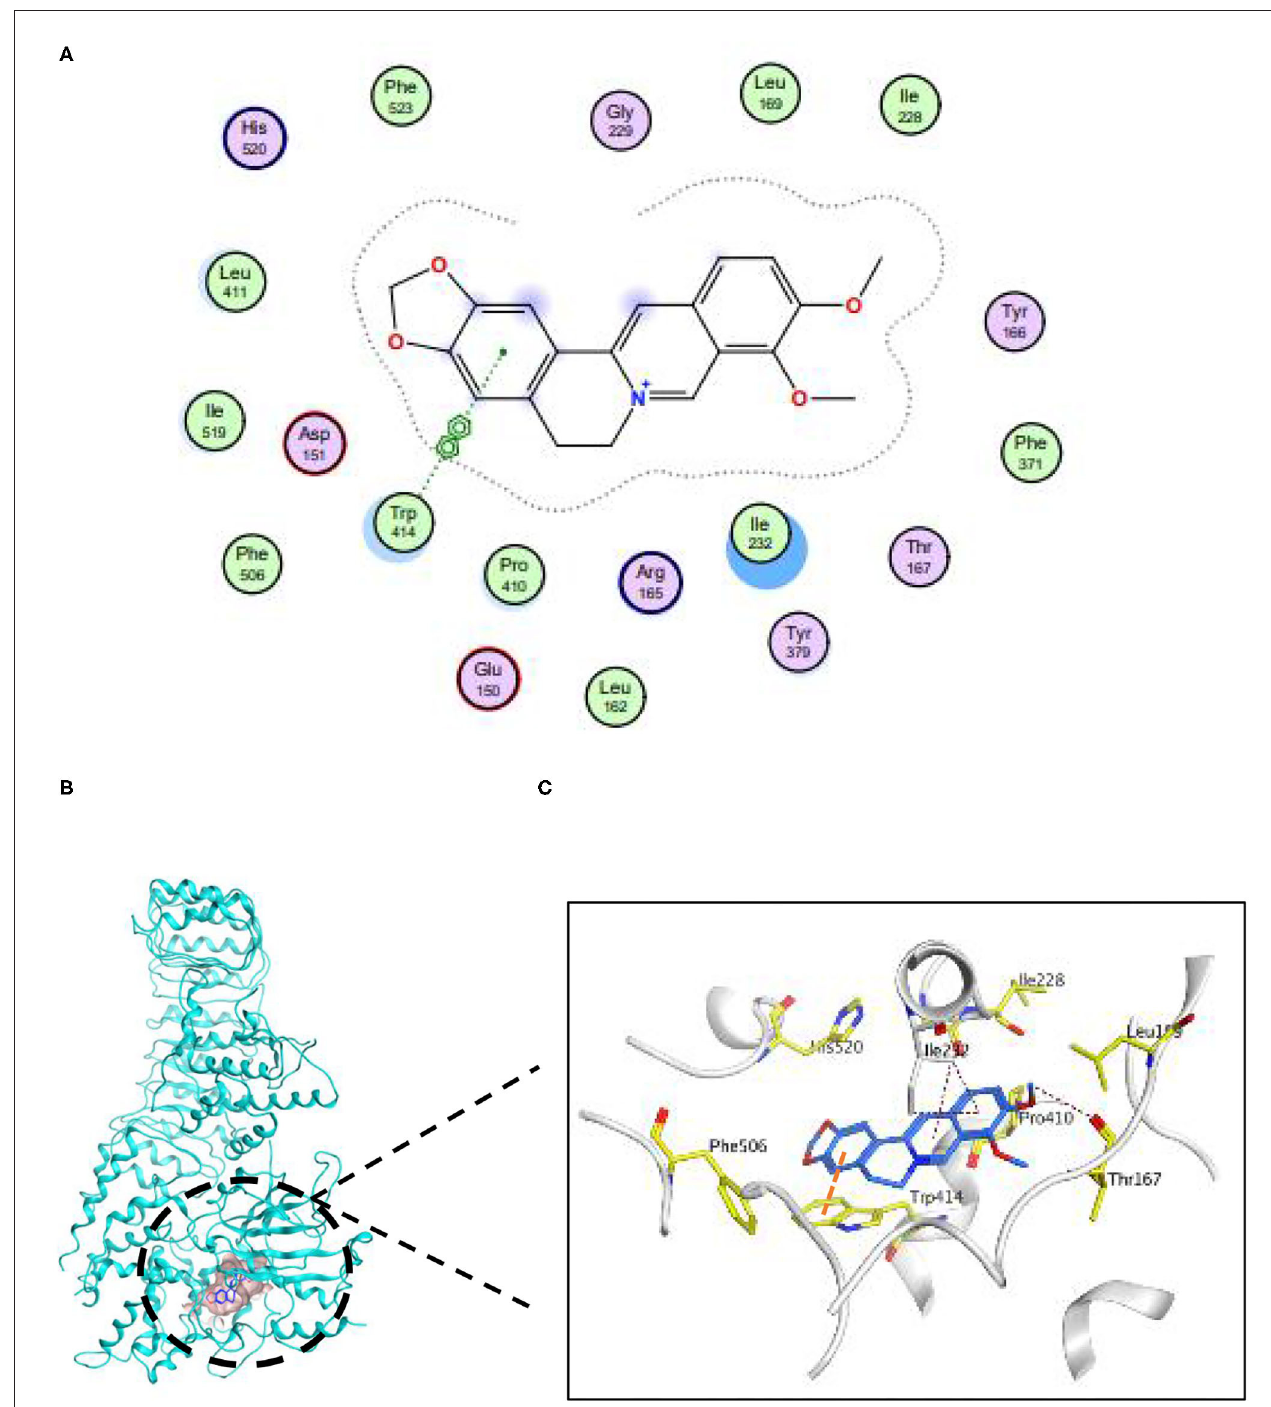
FIGURE 6 | Berberine was capable of establishing conformation with Nlrp3. (A) The 2D binding pattern of BBR and Nlrp3. (B) The binding model of BBR on molecular surface of Nlrp3. The molecular surface of Nlrp3 was colored in pale blue and BBR was colored in cyan. (C) The 3D binding mode of BBR and Nlrp3.